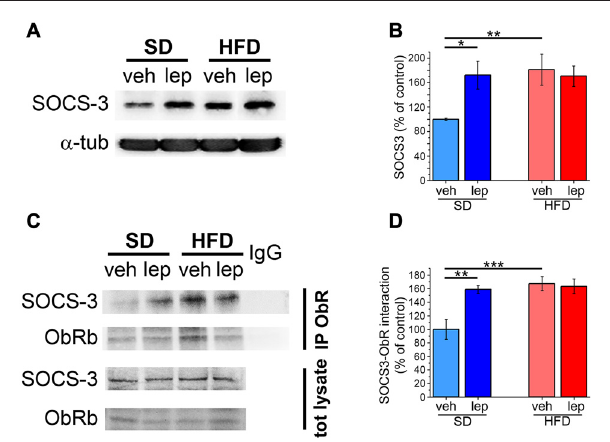
FIGURE 5 | The SOCS-3 inhibitory pathway is altered in HFD mice. (A) Representative images showing immunoblottings for SOCS3 and α -tubulin. (B) Quantification of SOCS-3 levels (SD-veh n = 5, SD-lep n = 5, HFD-veh n = 5, HFD-lep n = 5; ANOVA-2, diet × treatment interaction, p = 0.045, followed by Bonferroni post hoc test, SD-lep vs. SD-veh, ∗ p = 0.016, SD-veh vs. HFD-veh, ∗∗ p = 0.008). (C) Representative images showing immunoblottings for SOCS-3 after immunoprecipitation using an anti-ObRb antibody and for the total protein lysates. (D) Quantification of SOCS-3-ObRb interaction from immunoprecipitates (SD-veh n = 5, SD-lep n = 5, HFD-veh n = 4, HFD-lep n = 6; ANOVA-2, diet × treatment interaction, p = 0.012, followed by Bonferroni post hoc test, SD-lep vs. SD-veh, ∗∗ p = 0.002; SD-veh vs. HFD-veh, ∗∗∗ p <